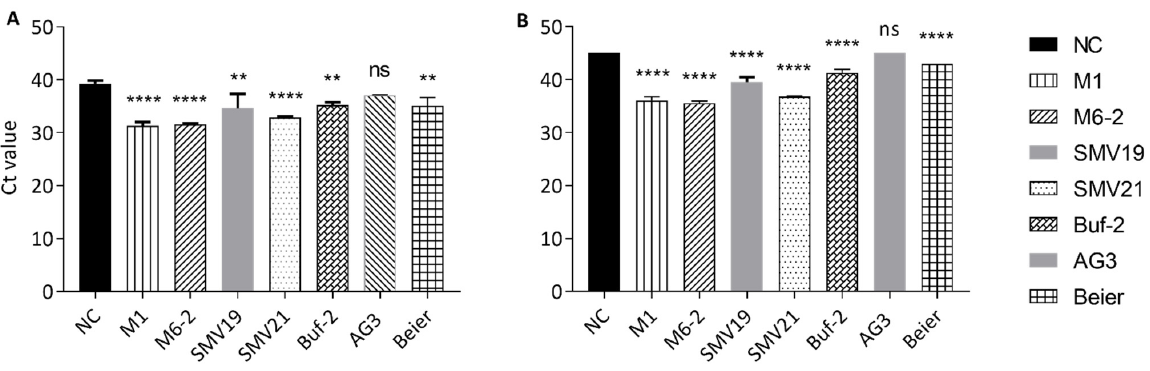
Figure 4. Aptamer-mediated NoV pull-down from stool suspension using different aptamers. The Ct values are shown on the y -axis, and each bar on the x -axis represents the aptamer used during the pull-down. Statistically significant differences compared to the negative control (NC) are indicated with asterisks above each bar. The p -value indication for the asterisks is: not significant (ns) for p -value > 0.05, two asterisk (**) for p -values between of 0.0021–0.0332 and four asterisks (****) for p -values < 0.0001. The aptamer mediated pull-downs were completed for each aptamer in triplicate from a 100-fold dilution from partially purified stool ( A ) and 1000-fold dilution of the same preparation ( B ). In ( B ) no Ct values were obtained for NC and AG3. Therefore, the maximum number of cycles run in the PCR program (45) is shown.